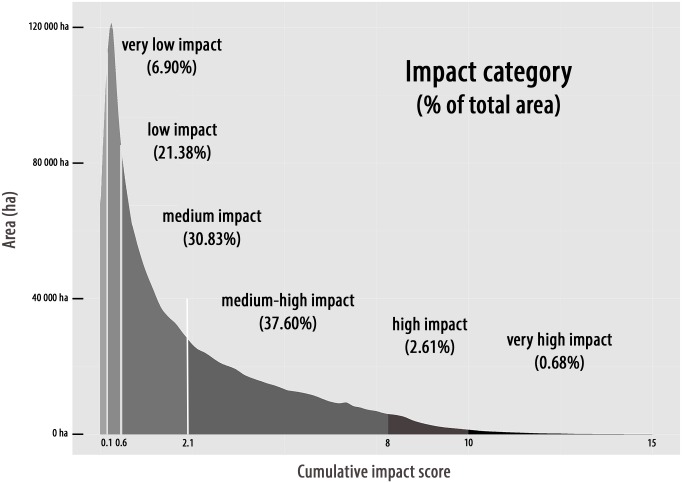
Cumulative impact scores (I
C) depicting the area (in ha) and the percent of total area (in parentheses) that falls within each impact category.